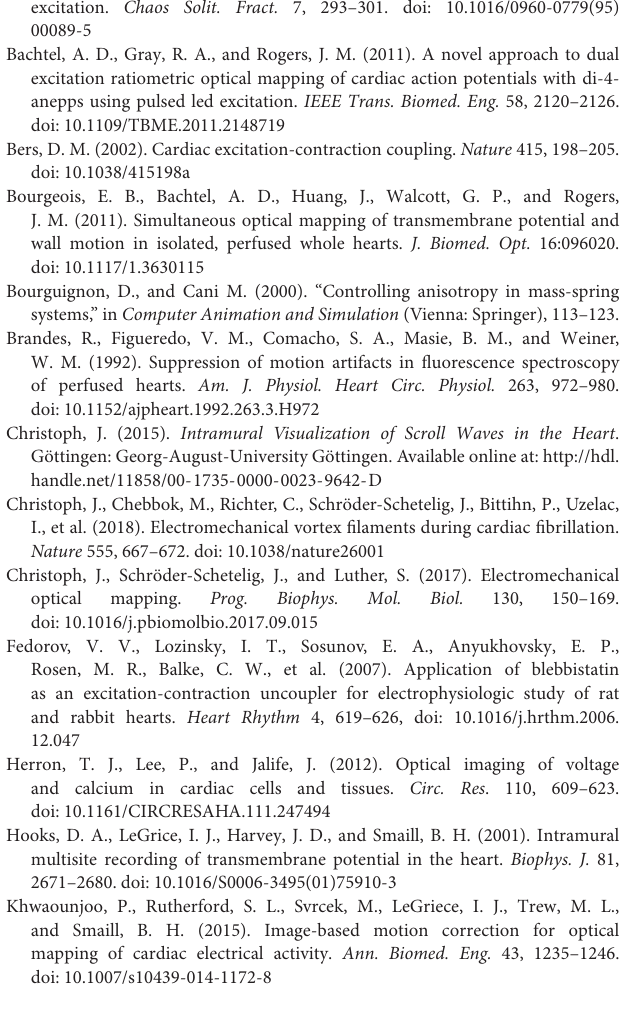
Supplementary Video 1 | Tracking of contracting and deforming left ventricular heart surface of a rabbit heart during pacing and the onset of ventricular fibrillation.